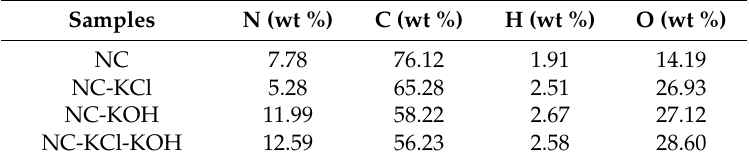
Table 9. The content of N, C, H and O in the typical samples determined by elemental analysis.